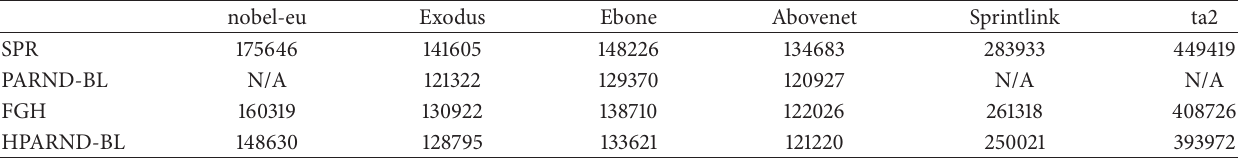
Table 7: Power consumption (W) versus topology—logarithmic curve, 𝑃 𝐶 V = 200 W. nobel-eu Exodus Ebone Abovenet Sprintlink ta2